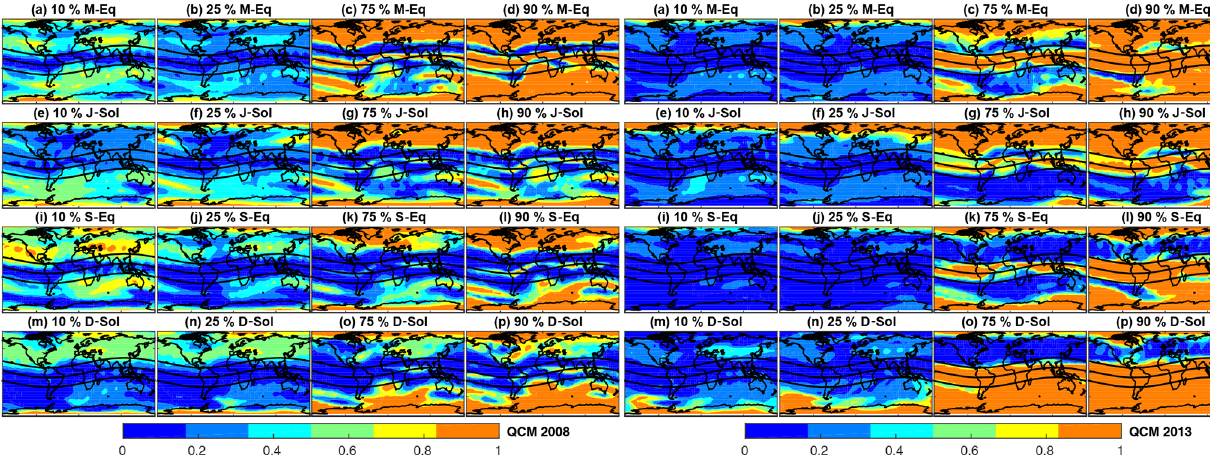
Figure 15. The same as Fig. 14 but for QCM.